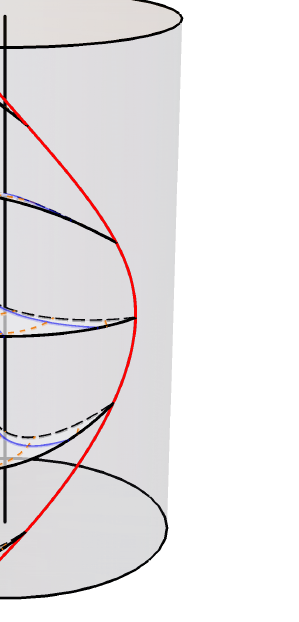
Figure 12 . The rapidly accelerating heavy conical deficit with A > ‘ − 1 , pushed by a strut, embedded within global AdS 3 . The deficit’s worldline is shown in solid black. Several surfaces of constant t are plotted. The surfaces x = x + and x 0 = x + are identified. Edges of x = x + are shown in long-dashed black within each time-slice. x + is taken positive enough that the entirety of the boundary is removed from the space before identification. The boundary of the classically accessible subset of the global boundary is shown in red. Lines of constant x are shown in blue, with lines of constant y in dashed orange. To guide the eye, the axis of the cylinder is also shown in